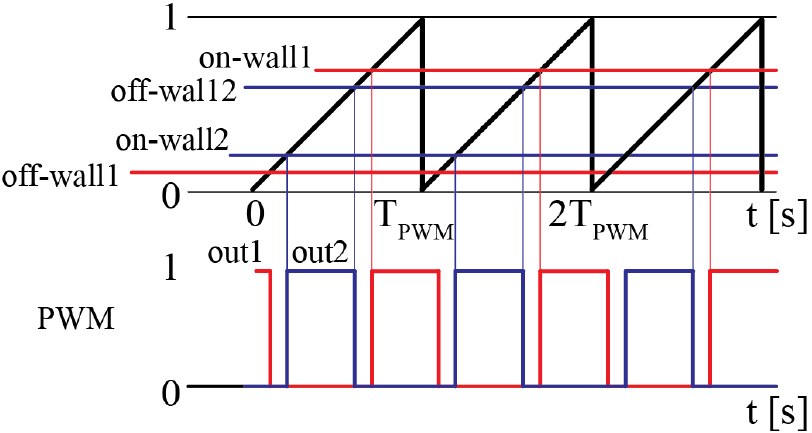
Figure 16. Asymmetric PWM generation